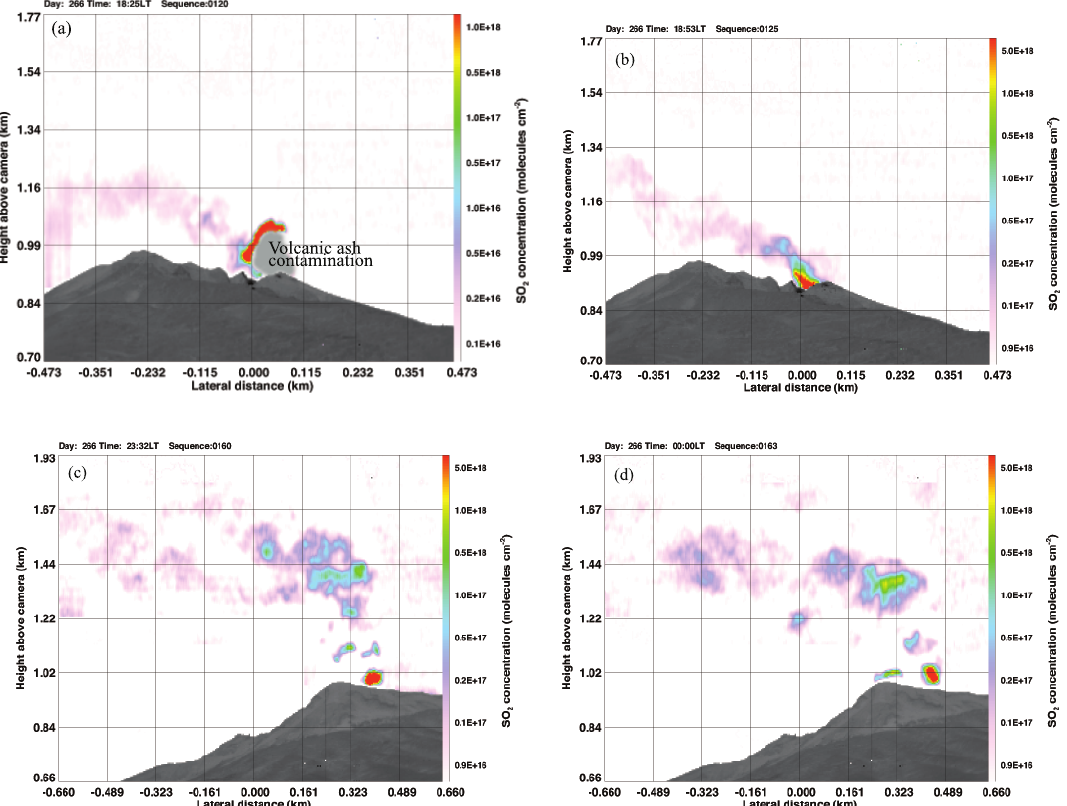
Figure 17. Stromboli SO 2 observed from two different sites, ∼ 1.7 and ∼ 2.3km from the active crater. (a) shows an image where there FIGURE 17. Stromboli SO observed from two different sites, (cid:24) 1.7 km and (cid:24) 2.3 km from the active was a small ash eruption obscuring the SO 2 . The “ashy” parts of the cloud can be masked out by using different channels. Local time 2 (LT) = UTC + crater. (a) shows an image where there was a small ash eruption obscuring the SO the cloud can be masked out by using different channels. Local Time (LT)=UTC+2.